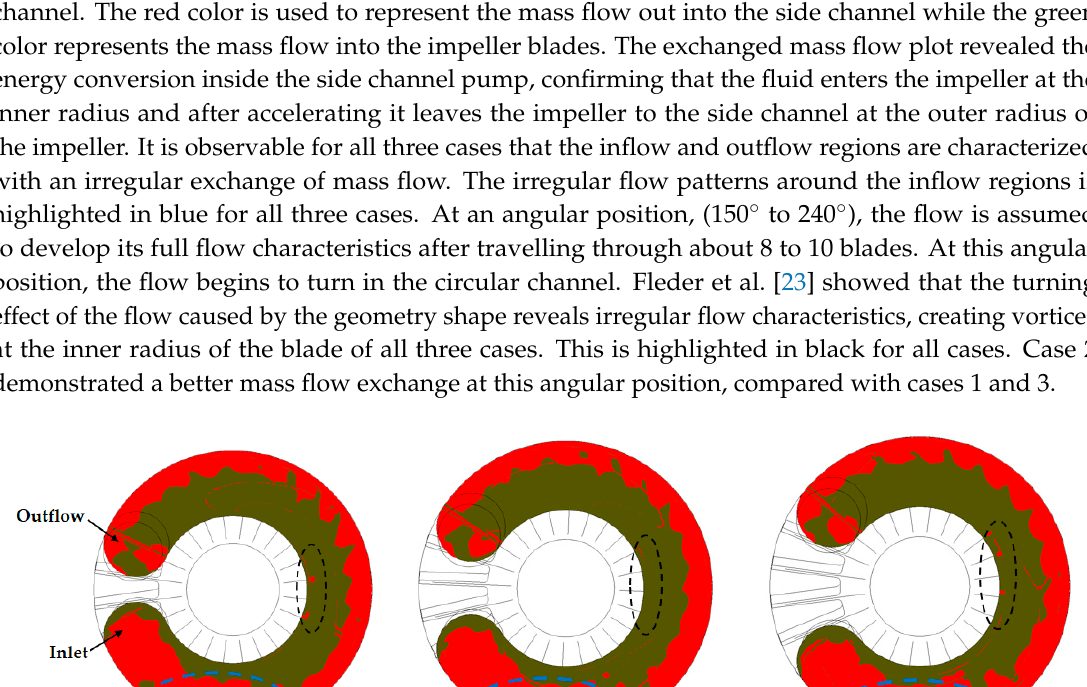
Figure 4. Pressure distribution in the impeller ( a ) Minimum head; ( b ) Maximum head.